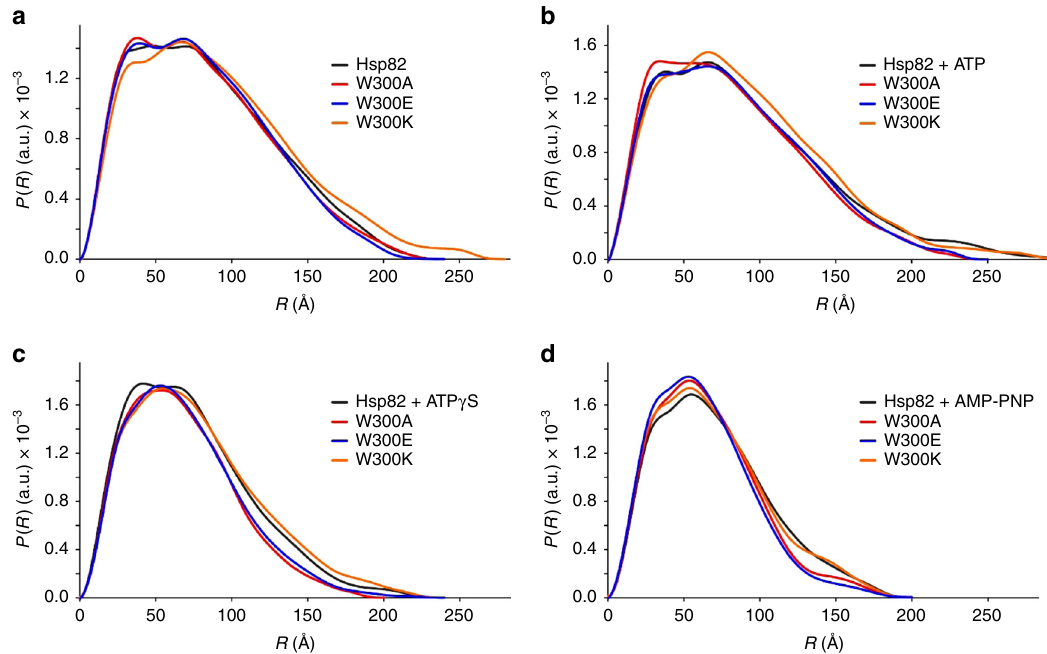
Fig. 4 SAXS-analysis of wt Hsp90 and Hsp90 W300-mutants. Measurements were performed as single-measurements at different sample concentrations ( n = 1). P ( R )-curves of wt and mutant Hsp82 (W300A/E/K) a in the absence of nucleotide, and b in the presence of 2 mM ATP, c ATP γ S, or d AMP – PNP. Black traces indicate wt Hsp90, red traces Hsp90 W300A, blue traces Hsp90 W300E and orange traces Hsp90